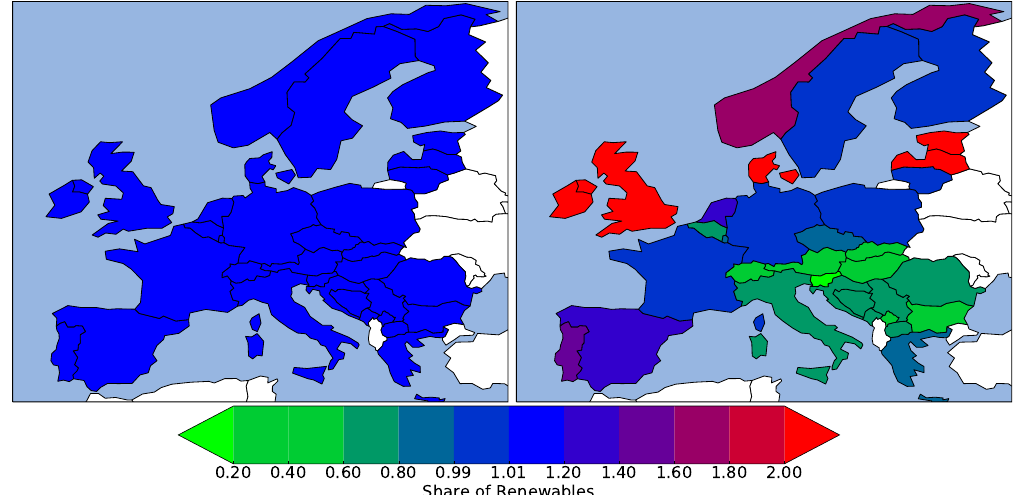
Figure 3. Shares of renewables ( α n , average renewable generation over consumption) for single countries in the homogeneous ( left ) and inhomogeneous ( right )